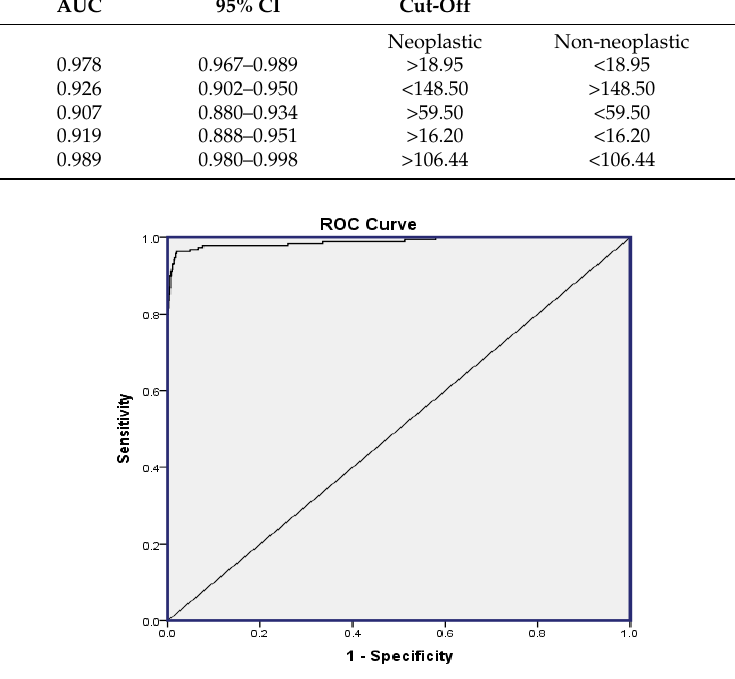
Table 2. ROC data of leukocyte CPD parameters used to distinguish neoplastic from non-neoplastic cases. Parameters